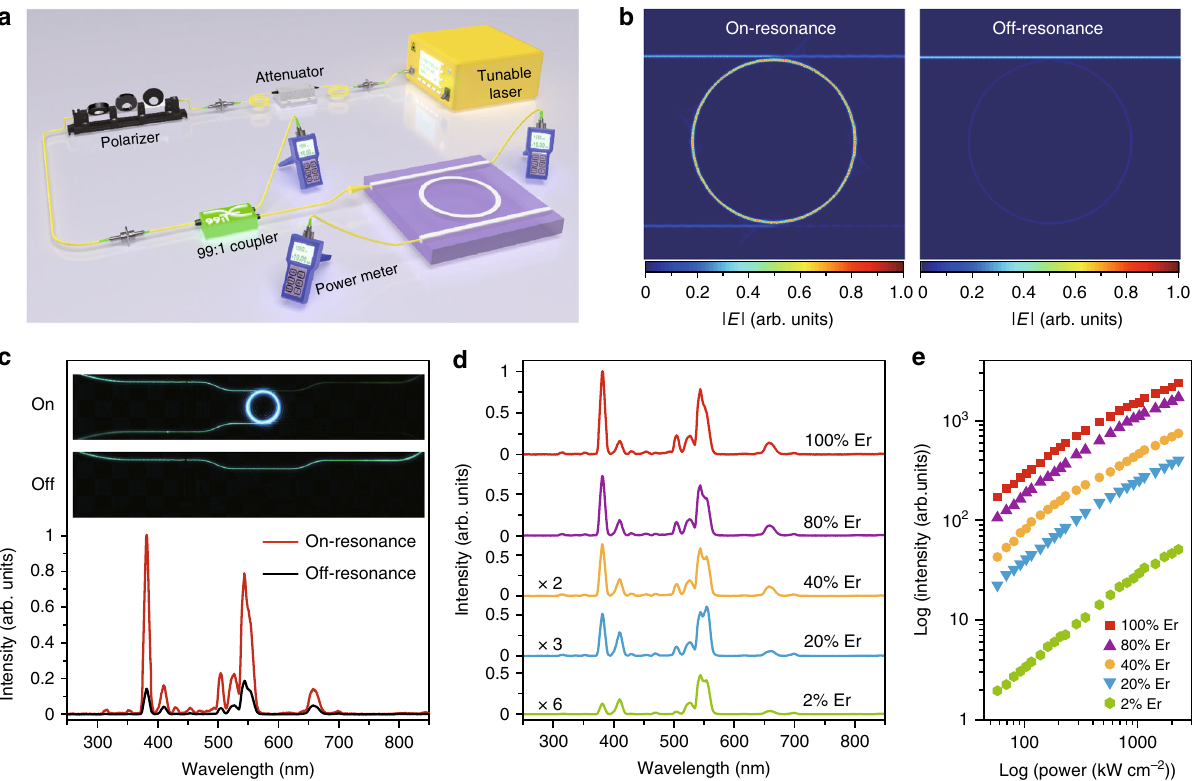
Fig. 4 Microring resonator-assisted excitation of NaErF 4 @NaYF 4 nanocrystals. a Schematic diagram of the set-up for the microring resonator-assisted excitation scheme. b Electrical fi eld distribution in the waveguide structure when the incident light is in resonance (left) and out of resonance (right) with the microring resonator. c Emission spectra and optical micrographs (inset) recorded from an identical specimen in different resonance states. d Emission spectra of NaYF 4 :Er (2 − 100%)@NaYF 4 nanoparticles as a function of Er 3 + concentration under microring resonator-assisted excitation (1549.47 nm, 2300 kW cm − 2 ). e Upconversion emission intensity at 382 nm as a function of excitation power density for NaYF 4 :Er (2 − 100%)@NaYF 4 on microring resonator, demonstrating attenuation of UV emission with decreasing Er 3 + excitation power (Fig. 4d, e). The observations are ascribed to a reduction in density of optical carriers, which diminish the absorption of surplus excitation light. A low Er 3 + content also disfavors interionic interaction and thus inhibits the ef fi cient energy transfer upconversion process.